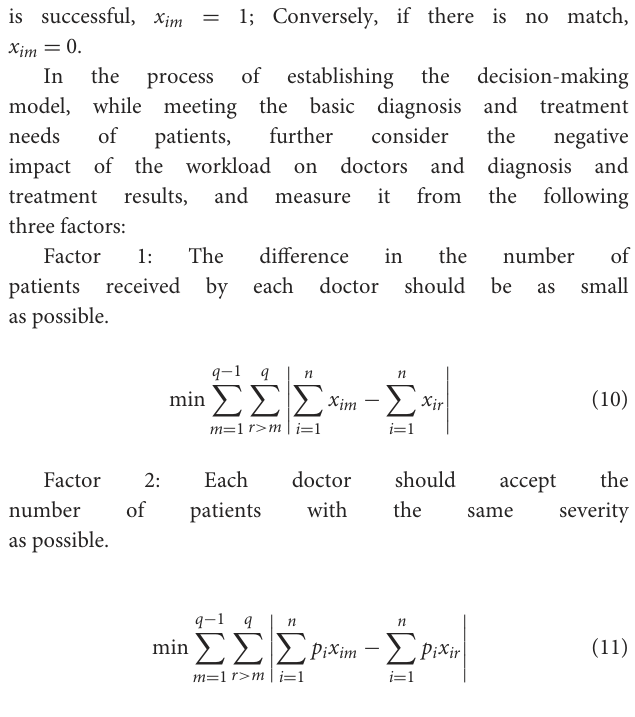
Estimated time of diagnosis (h)